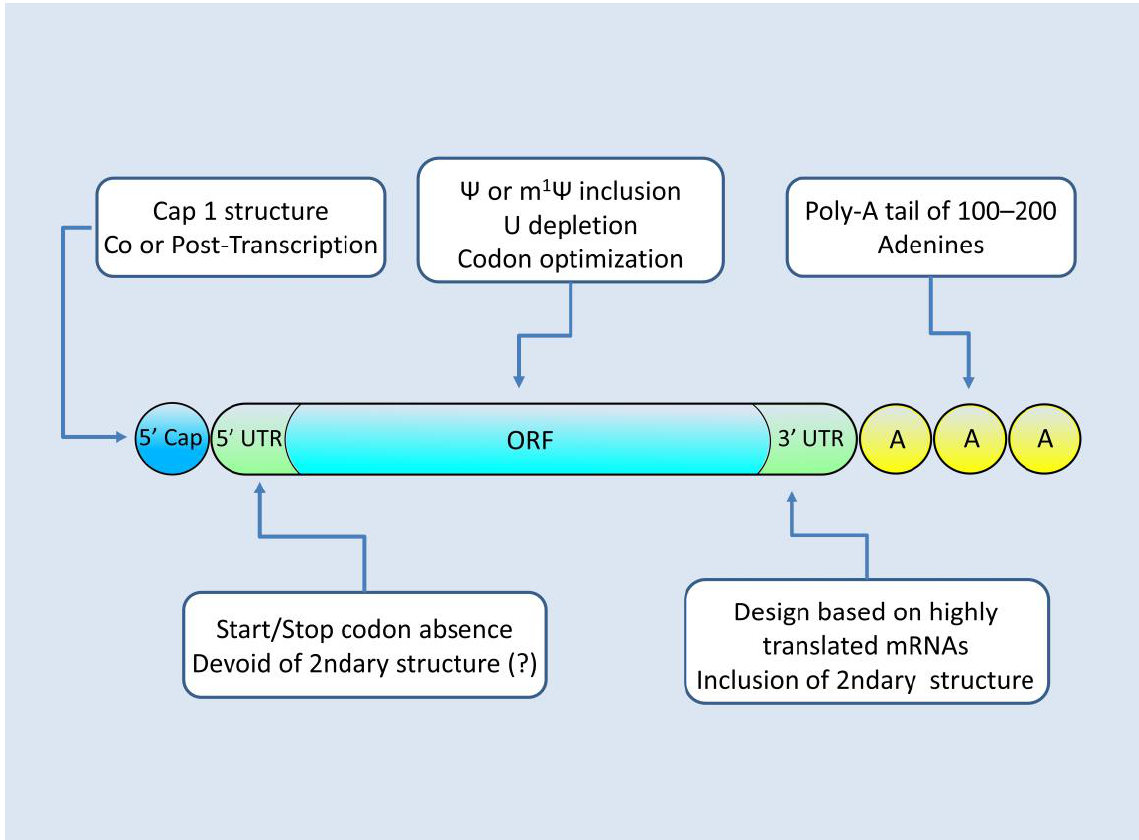
Figure 2. Architecture of modRNA. Modifications to the sequence (plasmid level) and to the chemistry (IVT level) allow for mRNAs with increased translational efficiency and minimal activation of the cell’s innate immunity mechanisms.